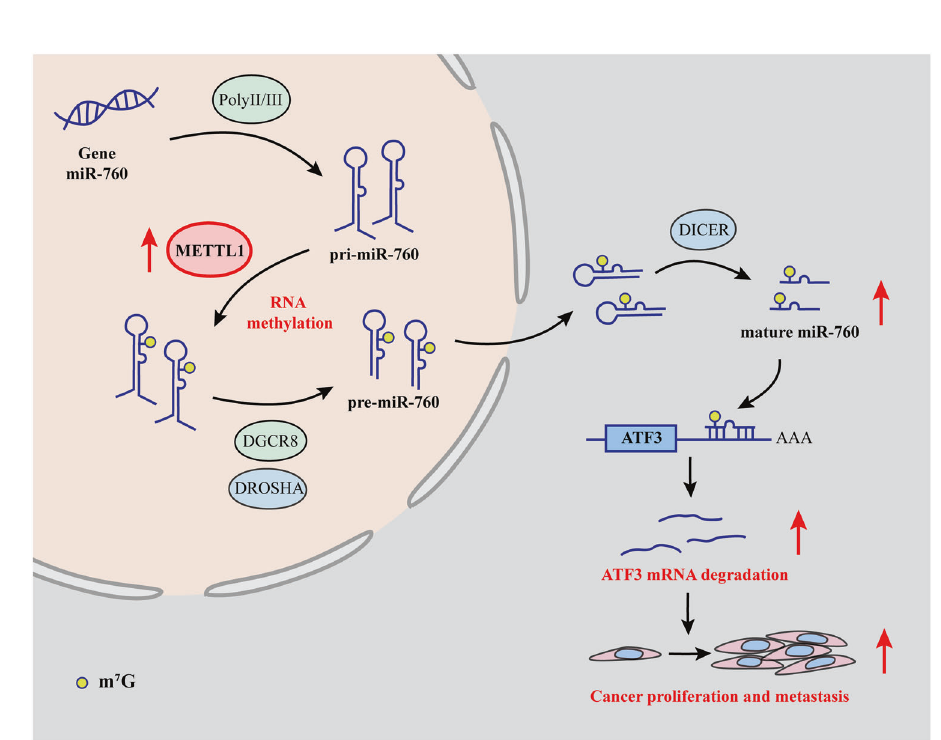
Fig. 7 Schematic of all fi ndings in this study. m 7 G modi fi cation of pri-miR-760 catalyzed by METTL1 promoted the processing of miR-760, which degraded ATF3 mRNA, driving cancer proliferation and cancer metastasis of D-luciferin Potassium Salt (15 mg/mL, PerkinElmer) per mouse. The metastases were analyzed by H&E staining. All animals were manipulated according to institutional guidelines and the permission granted by Sir Run Run Shaw Hospital, Zhejiang University.